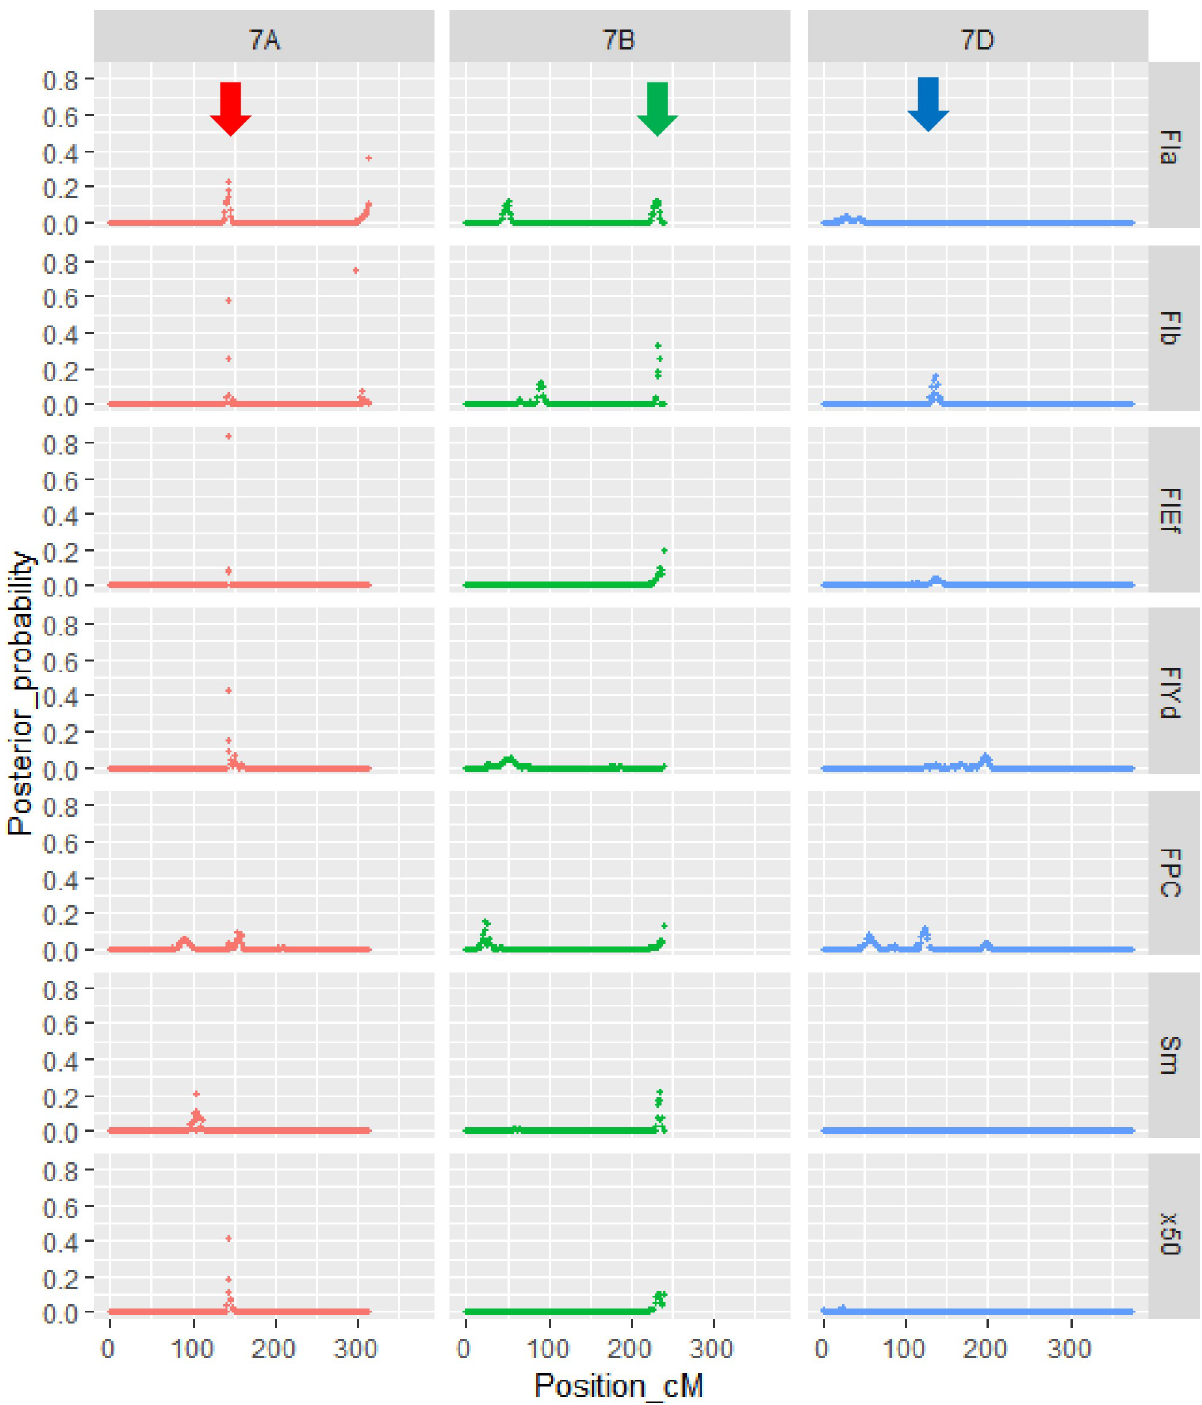
Fig 3. Posterior probabilities of the four traits along with group 7 chromosomes. Flour color a � (Fla), flour color b � (Flb), flour yield (FlYd) and flour protein content (FPC) QTLs were detected on group 7 chromosomes using multifamily Bayesian QTL analysis.